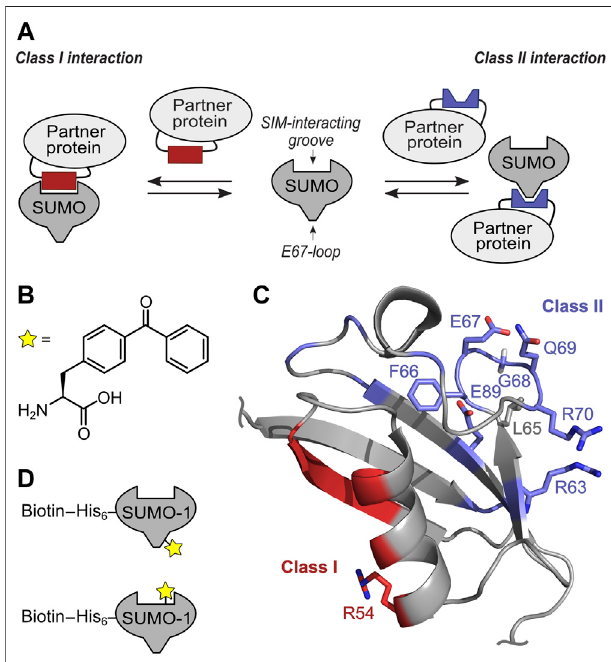
FIGURE 1 | Concept of targeting class I and II SUMO Interaction interface with selective SUMO-1 photo-crosslinking probes. (A) Scheme of SUMO-proteininteractionusingSIMinteractinggrooveandE67-loopbinding. (B) Structure of unnatural amino acid BzF utilized as photo-crosslinker. (C) NMRstructure(pdb-code:1A5R)ofSUMO-1.ResiduesinvolvedinclassII interaction are highlighted in blue and the positions tested for BzF incorporationareshownassticks.ResiduesformingtheclassIinteractionsite areshowninredandtheR54sidechainusedtoincorporateBzFishighlighted in sticksrepresentation. (D) Schemeofthe mono-SUMO-1 probescontaining BzF close to the E67 loop (top) and at R54 close to the SIM binding groove (bottom).BiotinwasconjugatedtoasinglecysteineinanN-terminalextension via maleimide chemistry.